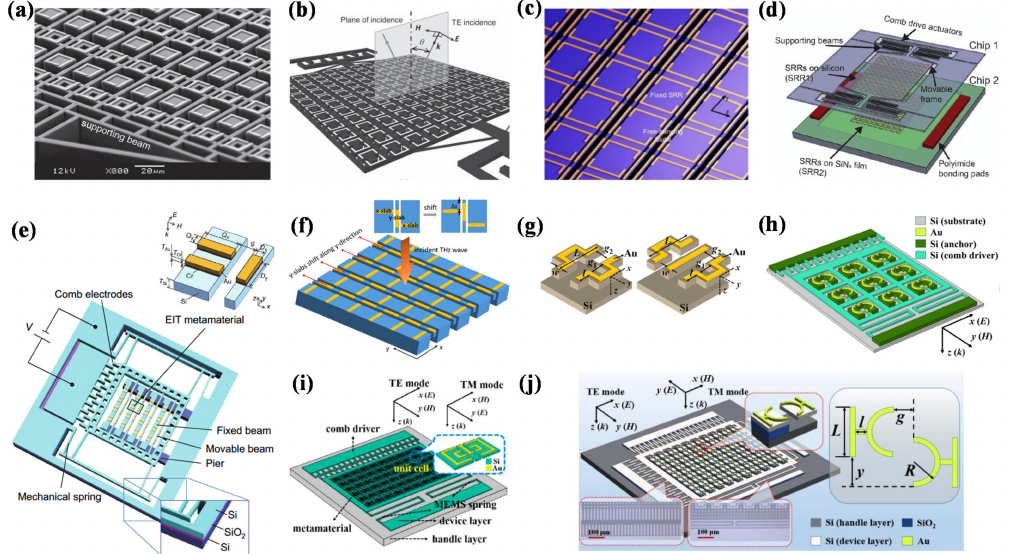
Figure 5. ESA-based horizontal tuning methods of metamaterial: ( a ) SEM images of the reconfigurable ASRRs metamaterial [80]; ( b ) schematic of the switchable magnetic metamaterial consisting of two semi-square split rings separated by a gap [81]; ( c ) schematics of the micromachined metamaterial with the element consisting of a two-cut SRR and two free-hanging slabs [82]; ( d ) schematic of the tunable metamaterials, including broadside-coupled SRRs (BC-SRRs) [83]; ( e ) schematic of the MEMS integrated device—unit cell of the EIT metamaterial consists of a cut wire and a wire pair [84]; ( f ) schematics of the tunable metasurface for the polarization conversion and the polarization rotation [85]; ( g ) schematics of polarization-sensitive IR metamaterials (PSIMs) [86]; ( h – j ) schematic of a tuning eSRR array by using comb drive horizontal tuning platforms